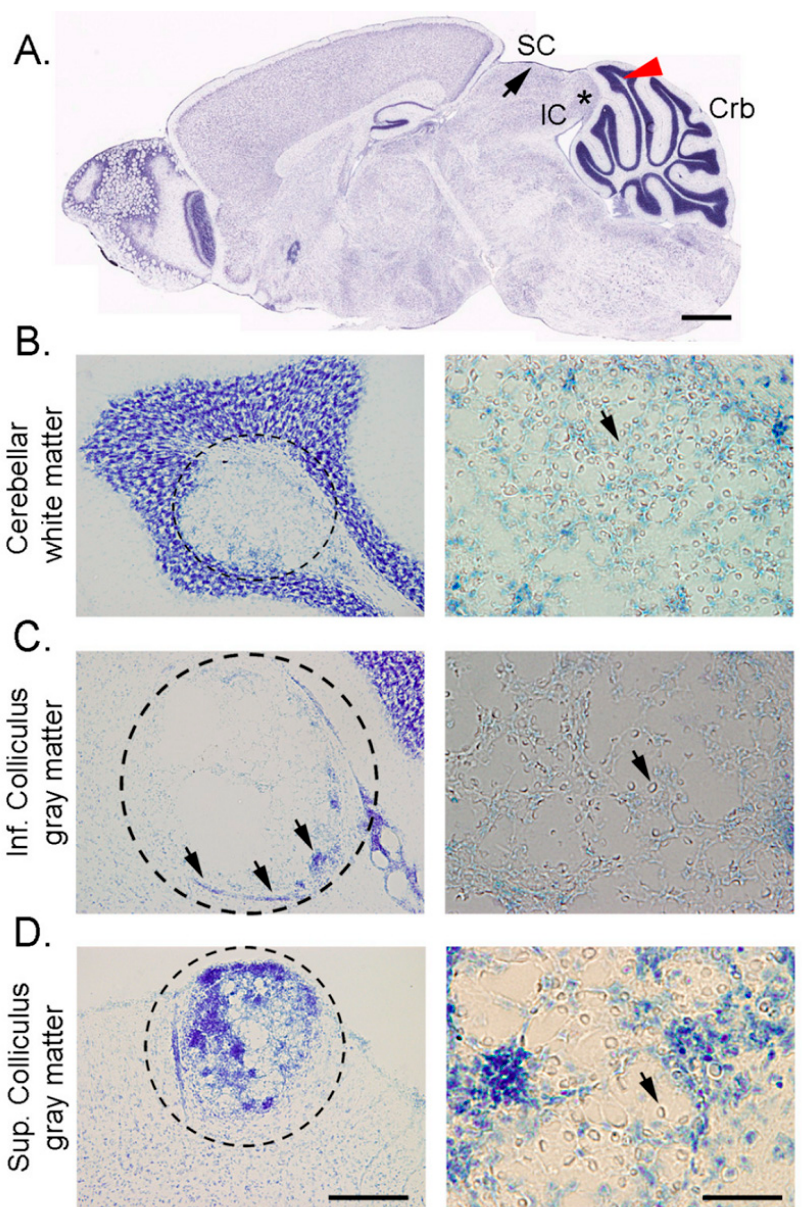
Figure 2. Cryptococoma formation in the gray and white matter of the midbrain and hindbrain 14 days after intratracheal inoculation of C. neoformans strain H99 in a C57BL/6J mouse. ( A ) Nissl-stained sagittal section indicating location of cyptococomas observed in the superior colliculus (SC; black arrow), inferior colliculus (IC; black asterisk), and cerebellum (Crb; red arrowhead); ( B ) Low- and high-magnification of a white matter cryptococoma (left and right panels) in the anterior cerebellum; ( C ) Low- and high-magnification of a white matter cryptococoma (left and right panels) in the inferior colliculus showing loss of parenchymal neurons and few macrophages except along the borders of the lesion (arrows); ( D ) Low- and high-magnification of a white matter cryptococoma (left and right panels) in the dorsal superior colliculus with marked presence of Nissl-stained microglia/macrophages. Panel A was adapted from the Allen Brain Mouse Reference Atlas (http://atlas.brain-map.org). Black arrows in right panels indicate cryptococcal cells. Scale bars: A = 1047 µm; B – D left panels = 200 µm; B – D right panels = 50 µm.